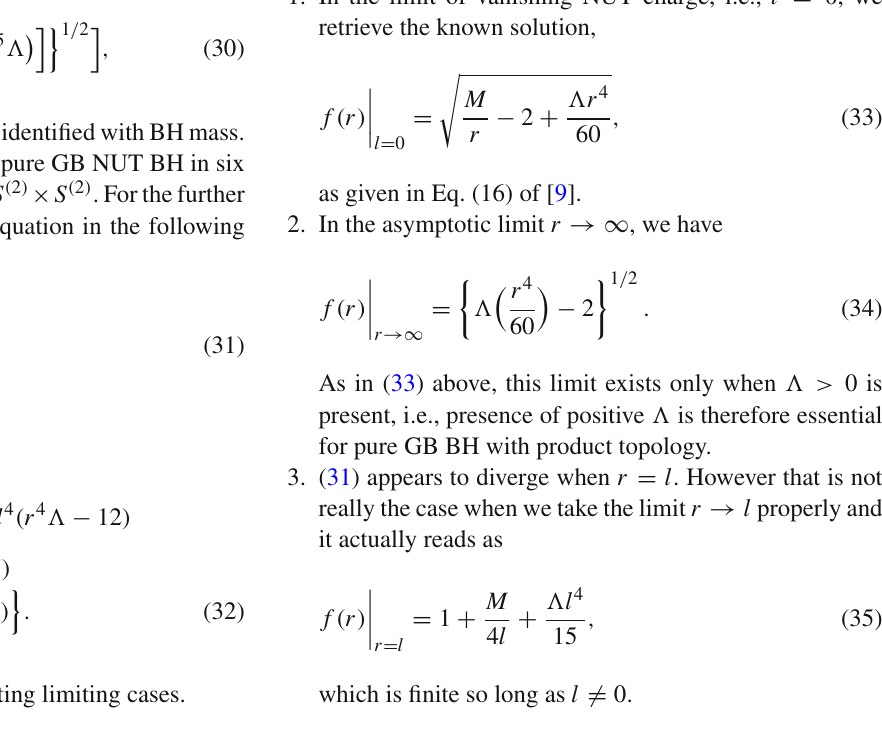
Fig. 2 The above figures demonstrate three possible cases with λ < 12, and each of the figures has (cid:2) M 4 = 0 . 06 (cid:3) + r 3 60 M − 120 r + r 5 (cid:2)